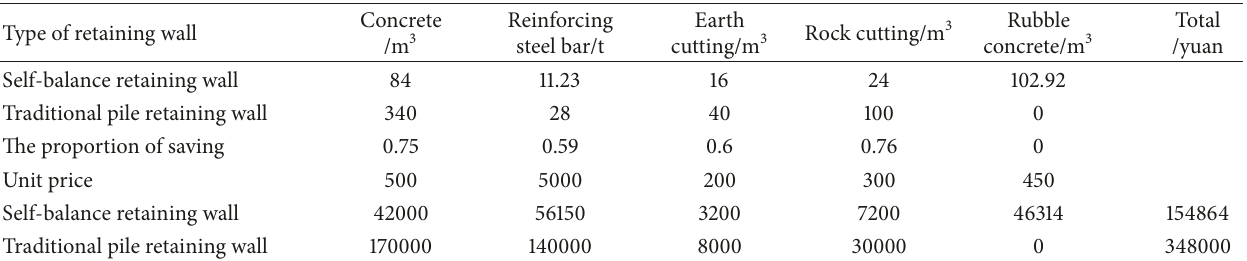
Table 3: Single pile quantity statistics and cost